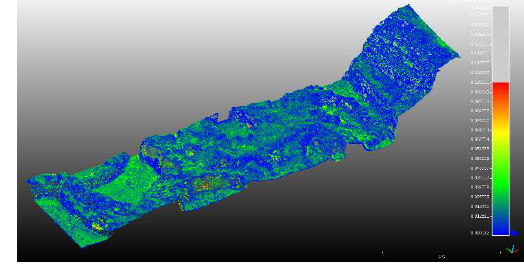
Figure 12. The UAV cloud compared to the LiDAR cloud. A sizeable (4cm) misalignment is shown in green points.